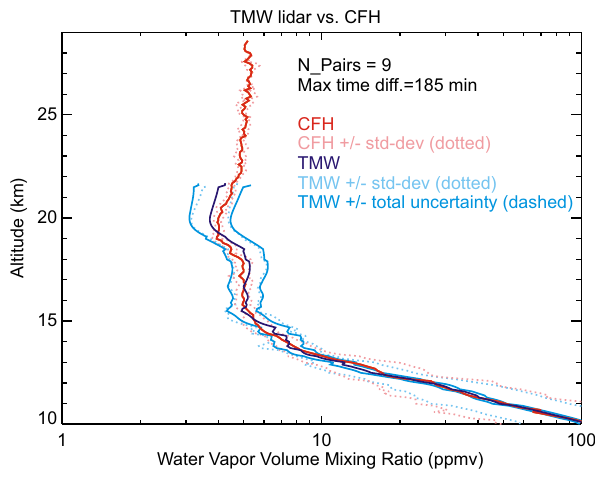
Fig. 7. Campaign-mean water vapor mixing ratio profiles in the UTLS obtained from the coincident 9 CFH launches and 9 TMW lidar nights ( ± 6h time